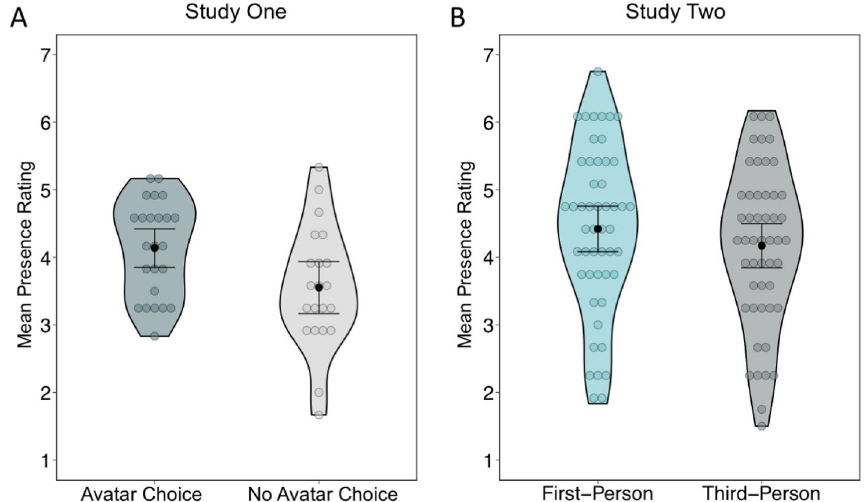
Figure 2. Sense of presence. ( A ) In Study One, there was a significant increase in the sense of presence when participants were able to choose their avatar compared to no choice. ( B ) In study Two, there was a significant increase in the sense of presence when virtual environments were experienced from a first-person compared to a third-person avatar perspective. Colored circles reflect mean for each participant, black circles represent the mean within each condition, and error bars reflect the 95%